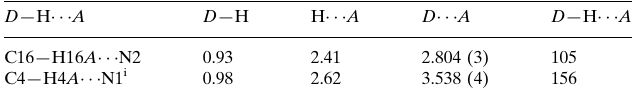
Hydrogen-bond geometry (A˚ , (cid:1)